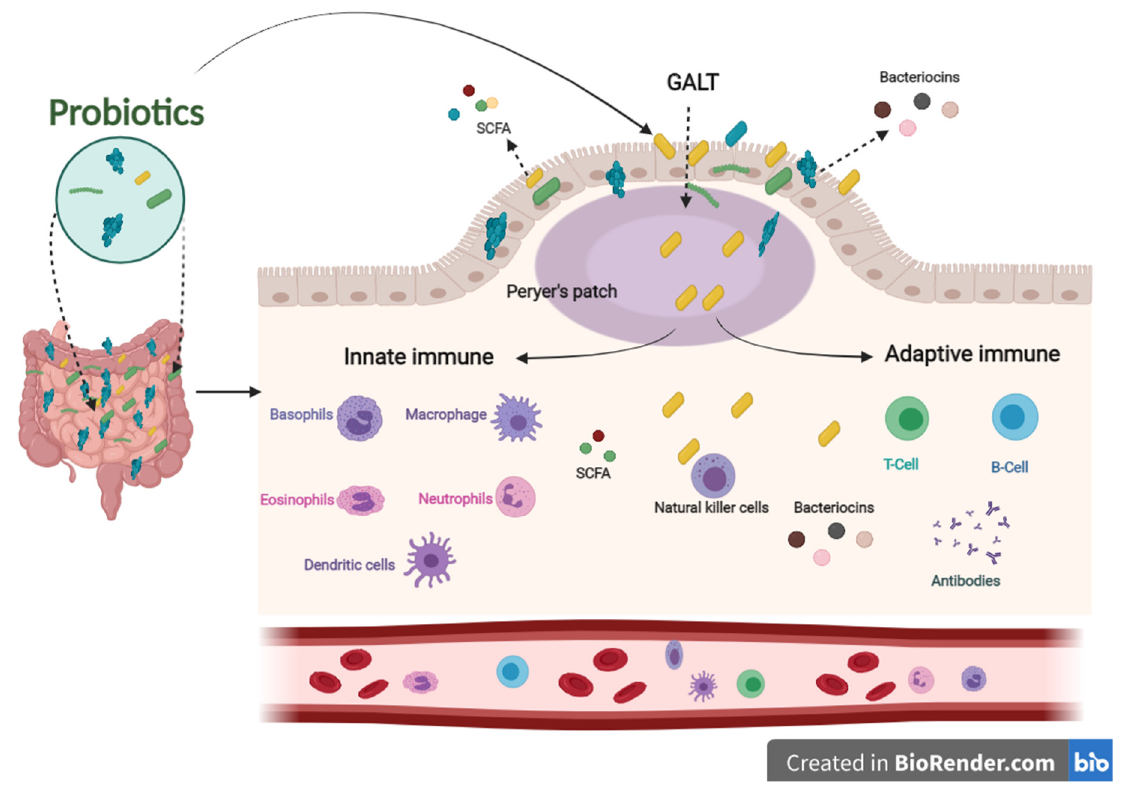
Figure 2. The influence of innate and adaptive immune responses by probiotics. When probiotics travel through Peyer’s patches, lead to an enhanced role of the immune system related to producing antigens and antibodies.